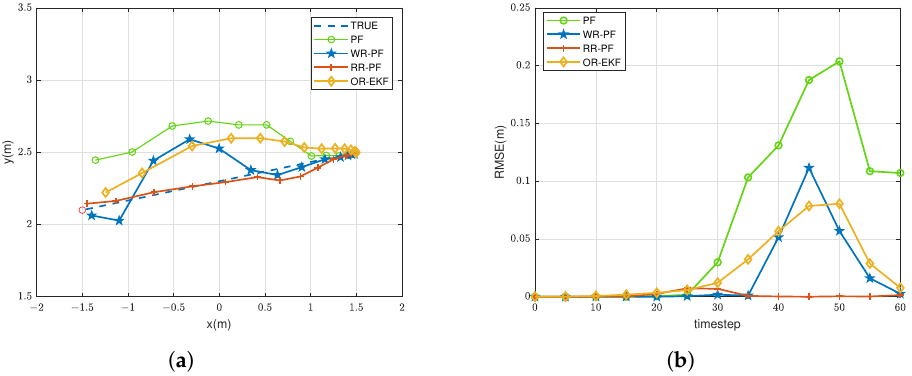
Figure 12. Performance comparisons of tracking results in the real data. ( a ) Tracking results based on real data. ( b ) RMSE